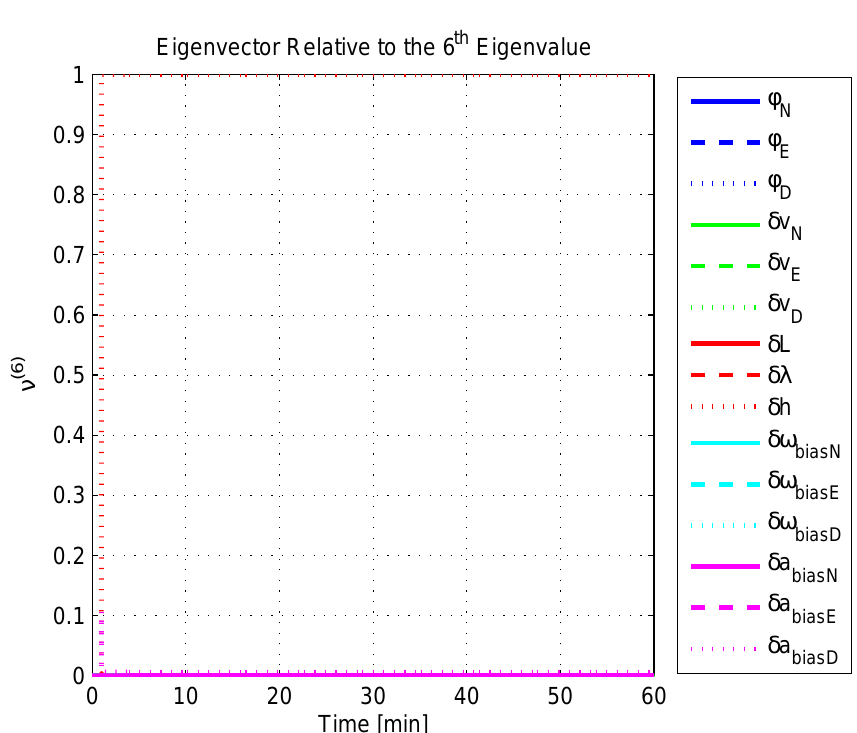
Figure 13. Eigenvector relative to the sixth eigenvalue in the simulated